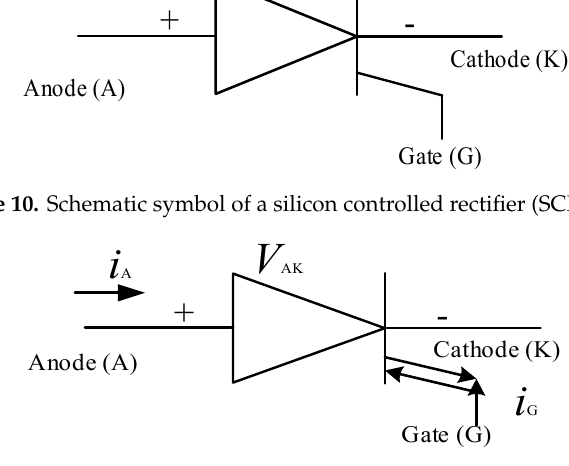
Figure 11. Schematic symbol of gate-turn-off thyristor (GTO) [134].